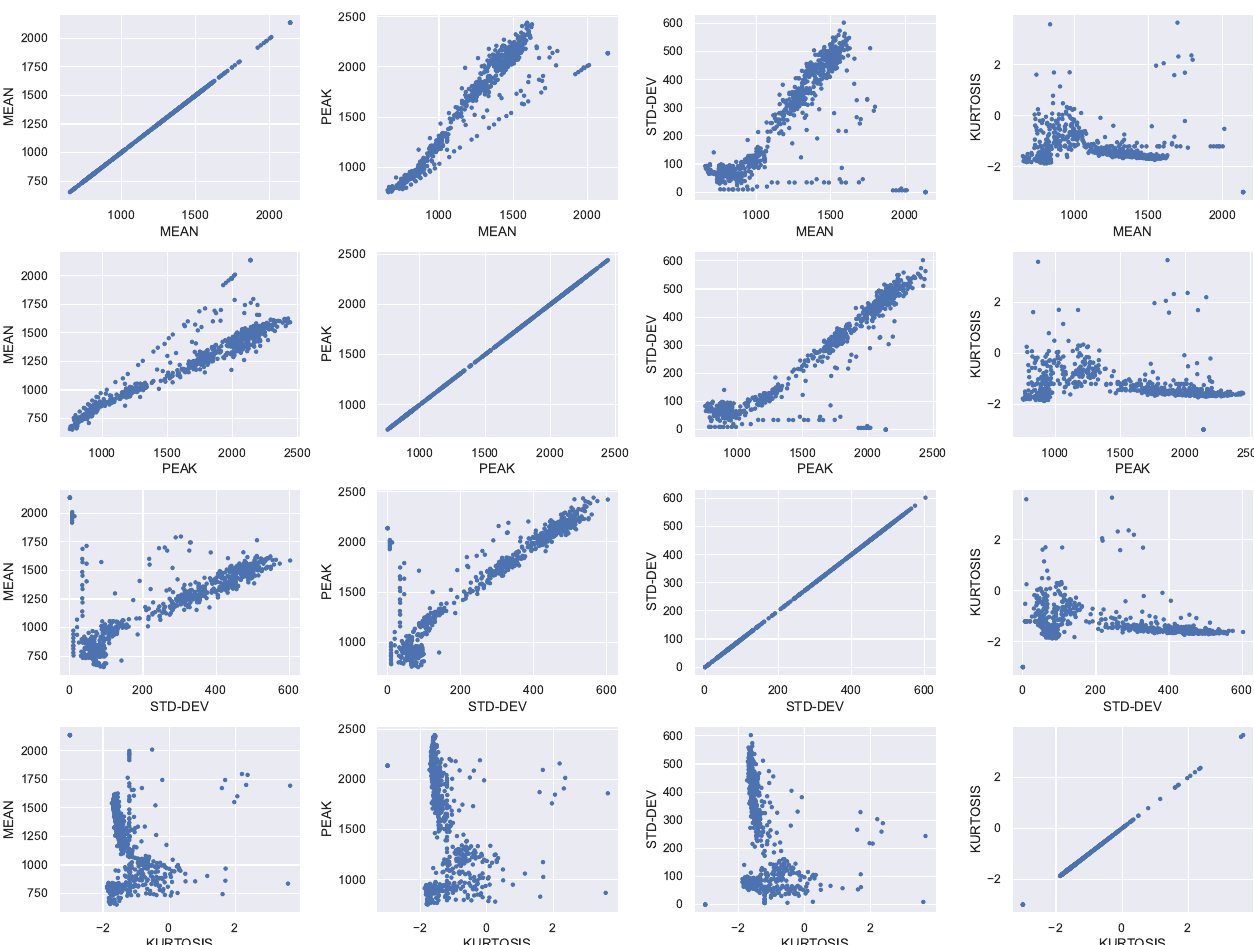
Figure 7. Histograms of geometric indicators.